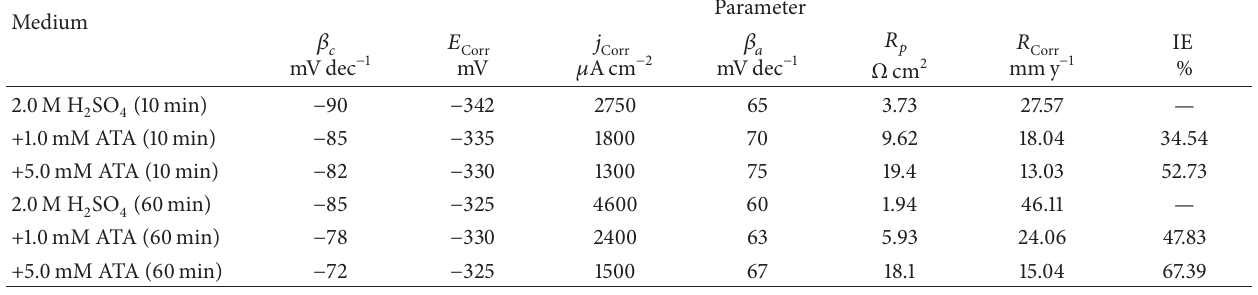
Table 2: Corrosion parameters obtained from the potentiodynamic polarization measurements for the HSLA steel electrode that was immersed for different periods of time in 2.0 M H Medium